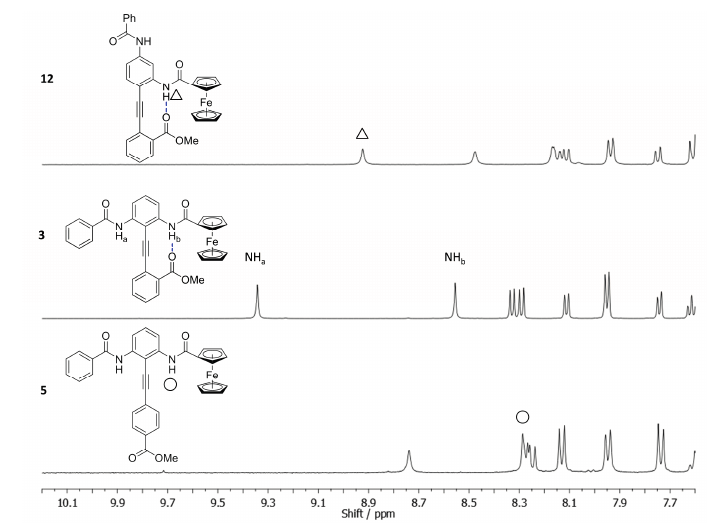
Figure 3. The 1 H-NMR conformational analysis for 3 using the 100% 12 and 0% 5 , peak assignments determined by NOE and COSY controls (4.0 mM, CDCl 3